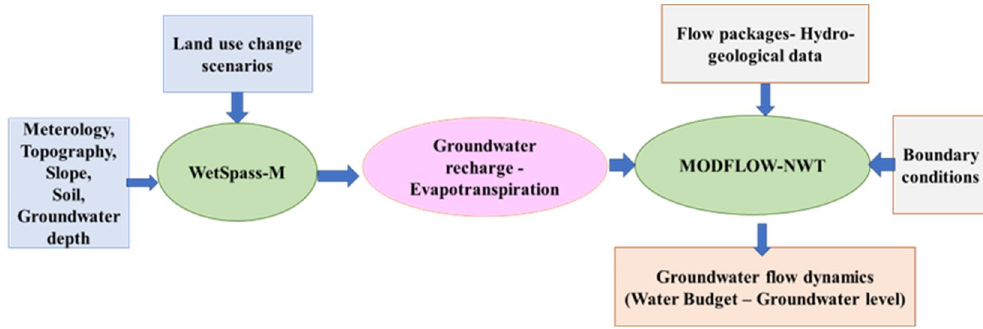
Figure 4. Adopted modelling